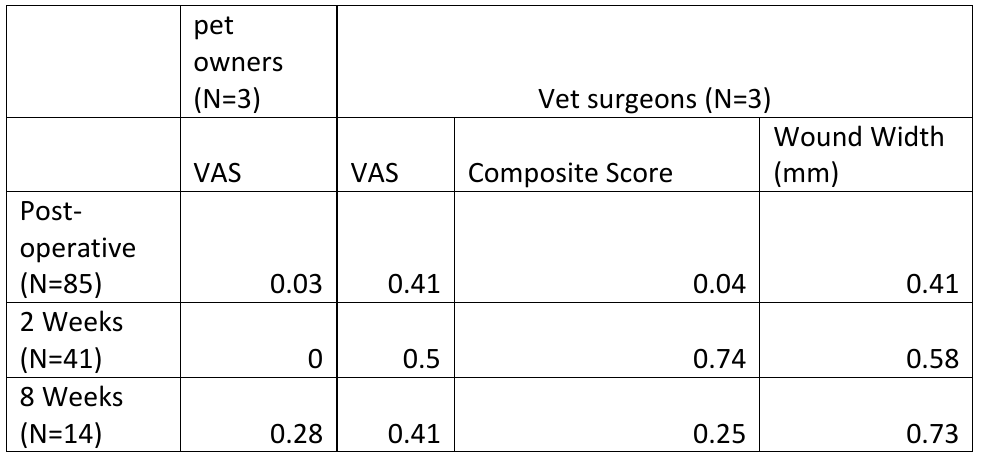
Table 2: Intraclass Coefficients of VAS, Composite Score, and Average Width to Evaluate Inter-rater Reliability